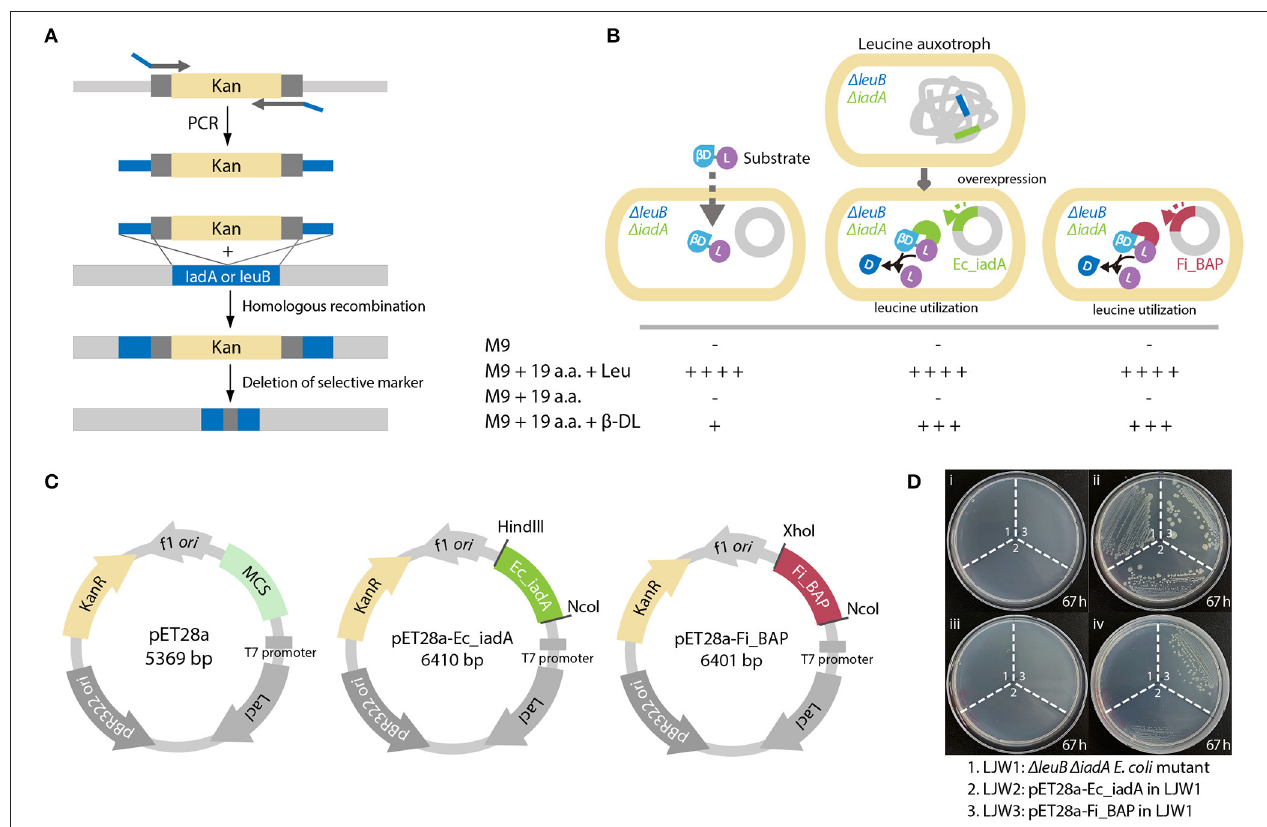
FIGURE 6 | Fi BAP complementation assay of the Leu auxotrophic leuB iadA E. coli double mutant grown on isoAsp peptides. (A) Strategy for obtaining the Leu auxotrophic 1 leuB 1 iadA E. coli double mutant using the RED/ET recombination method. (B) Comparison of growth phenotypes for three E. coli mutant strains (LJW1, the 1 leuB 1 iadA double mutant; LJW2, the LJW1 strain harboring the pET28a-IadA overexpression plasmid; and LJW3, the LJW1 strain harboring the pET28a- Fi BAP overexpression plasmid) grown in four different types of medium: (i) M9 minimal medium (M9); (ii) M9 minimal medium containing 20 amino acids (M9-20aa); (iii) M9 minimal medium containing 19 amino acids (Leu − , M9-19aa); and (iv) M9 minimal medium containing 19 amino acids (Leu − ) and 1.6mM β -Asp-Leu (M9_19aa_ β -DL). Expected growth phenotypes are marked as + or –. (C) Schematic representation of plasmid construction for recombinant proteins. Genes encoding Ec IadA and Fi BAP were ligated into the pET28a expression vector digested with appropriate restriction enzymes. (D) Photographs of three E. coli mutant strains on various M9 plates after a 67h incubation at 37 ◦ C.